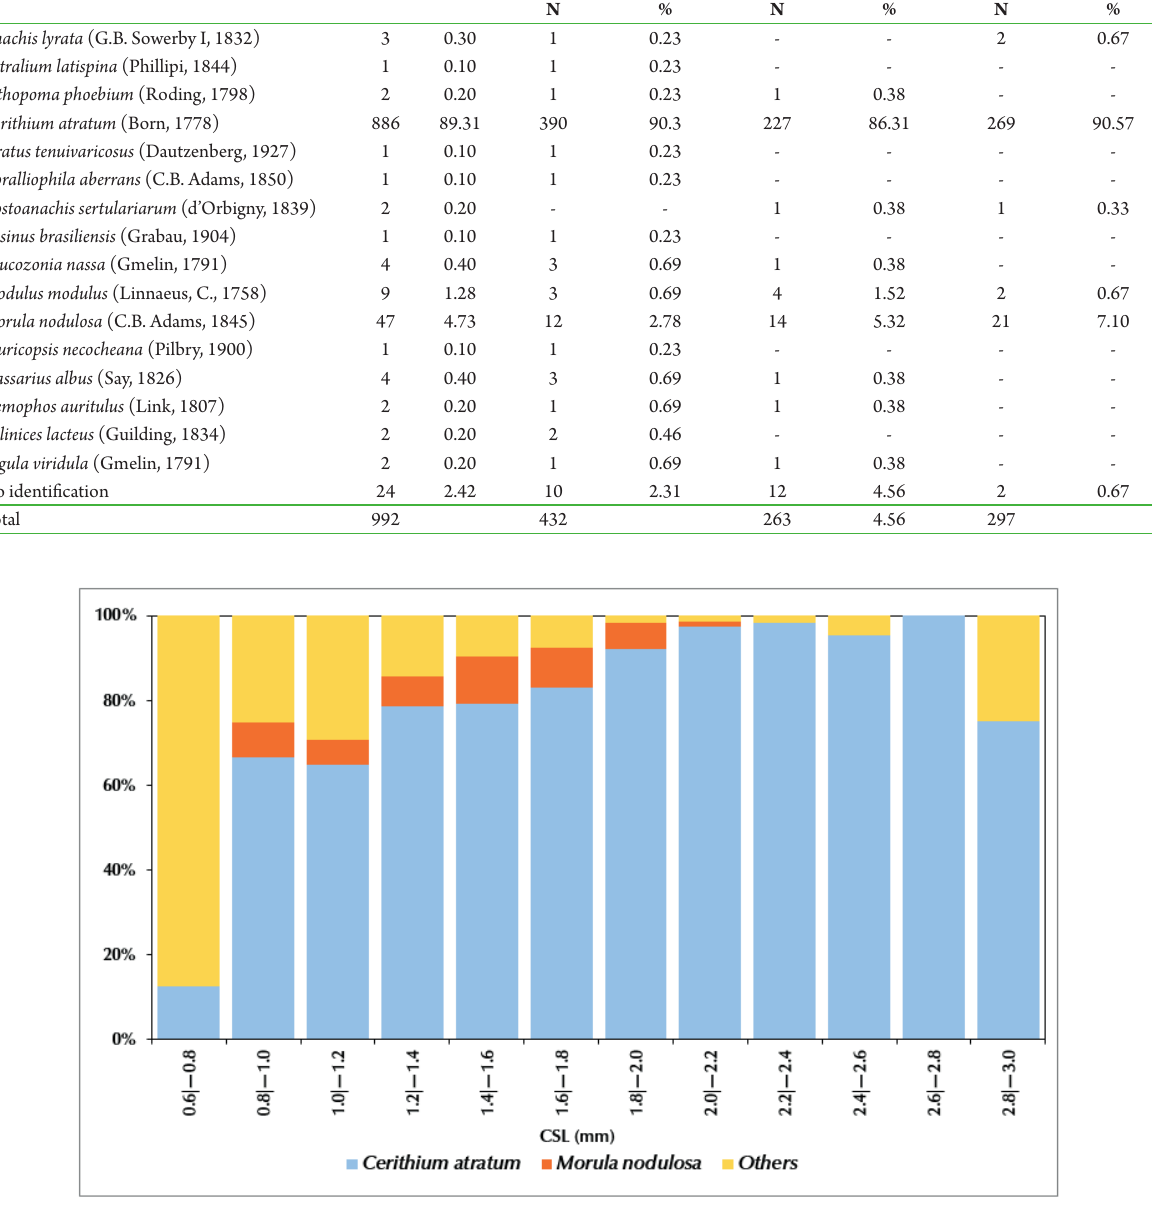
Table 1. List of gastropod shells occupied by Pagurus criniticornis at Anchieta Island, São Paulo, Brazil. Species